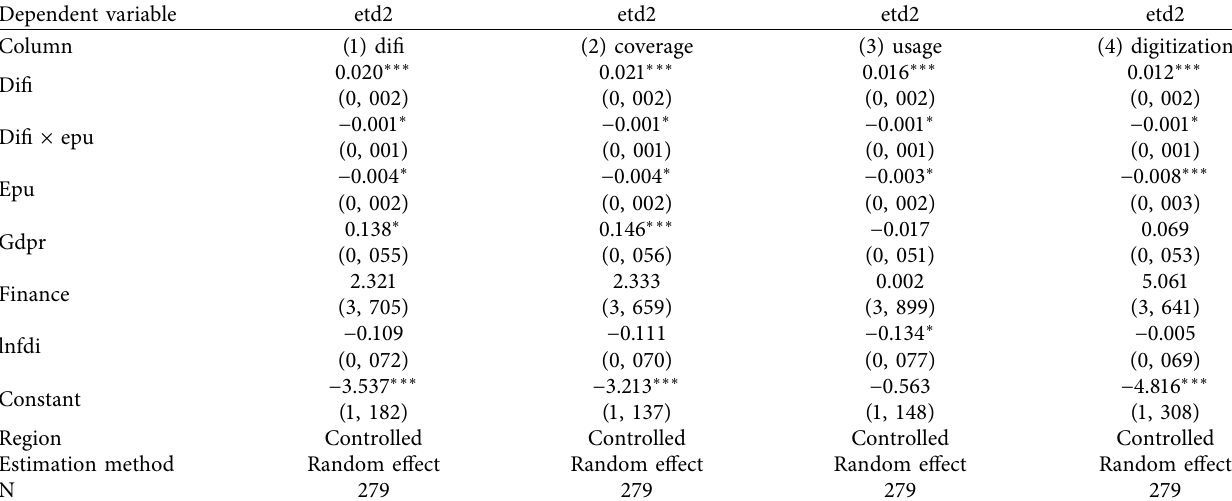
Table 7: Robustness test of capital’s diversion from the fictitious to the substantial economy